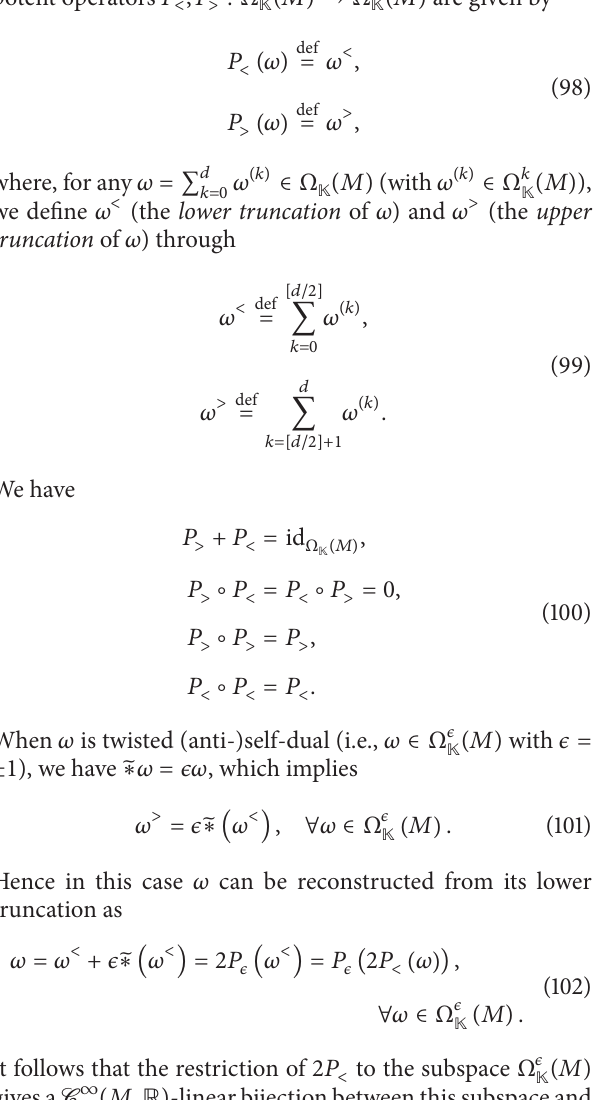
Table 1: Properties of ] according to the mod 8 reduction of 𝑝 − 𝑞 for the case K = R . At the intersection of each row and column, we indicate the values of 𝑝 − 𝑞 (mod 8) for which the modified volume form ] has the corresponding properties. In parentheses, we also indicate the isomorphism type of the Schur algebra for that value of 𝑝 − 𝑞 (mod 8). The real Clifford algebra cl (𝑝,𝑞) is nonsimple iff 1,5 , which corresponds to the upper left corner of the table. 𝑝−𝑞 ≡ 8 Notice that ] is central iff 𝑑 is